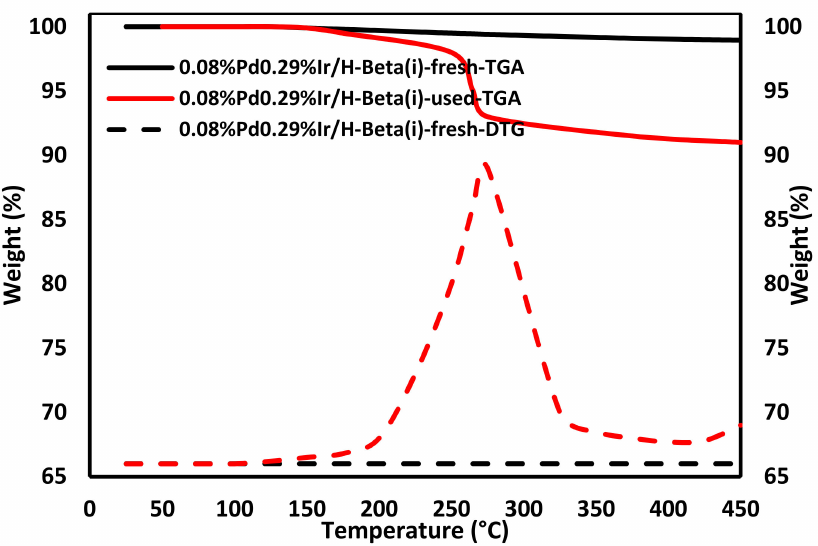
Figure 14. Thermal Gravity Analysis-derivative thermogravimetry (TGA-DTG) patterns of fresh and used 0.08%Pd0.29%Ir/H-Beta(i) catalyst after work in 55 ◦ C, p = 20 bar, R = 3, GHSV = 4030 h − 1 for 15 h, and reduction at 150 ◦